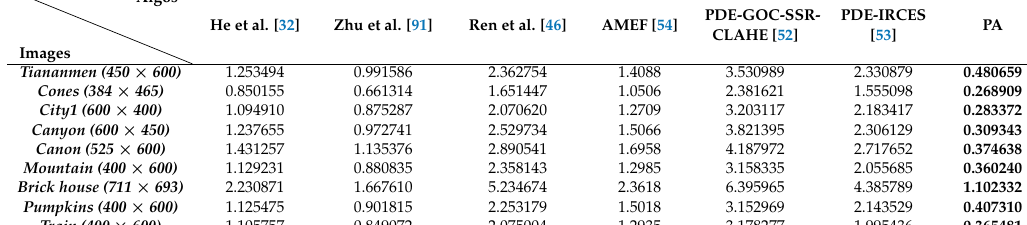
Table 3. Runtimes for hazy images processed with He et al. [32], Zhu et al. [91], Ren et al., AMEF,